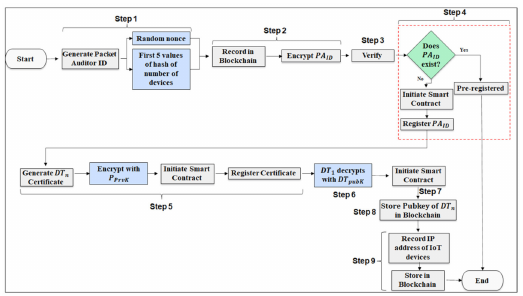
Figure 2. Packet Auditor and Digital Twin